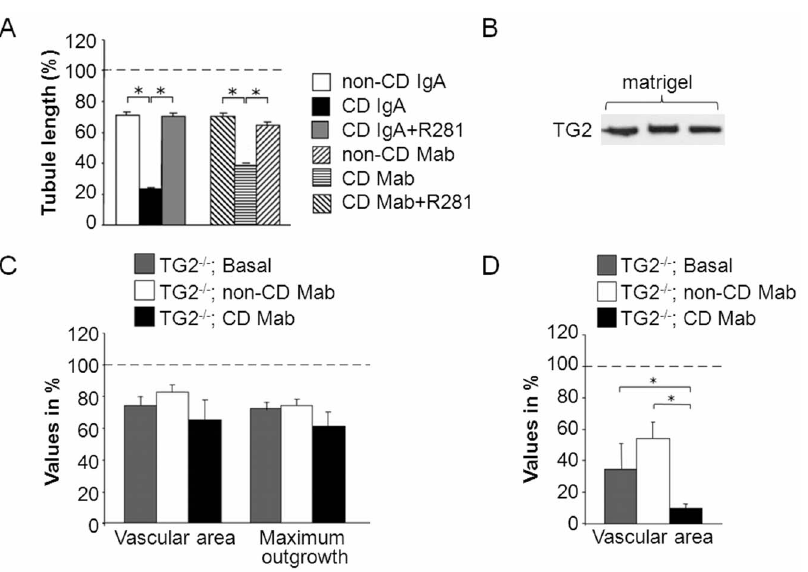
Figure 6. The contribution of extracellular transglutaminase 2 (TG2) in the anti-angiogenic response exerted by celiac antibodies. (A) Endothelial tubule length in three-dimensional human umbilical vein endothelial cell (HUVEC) cultures in the presence of celiac patient-derived total IgA (CD IgA) or monoclonal antibodies (CD Mab), or their relevant controls (non-CD IgA or non-CD Mab) and with/without TG2-inhibitor R281. All data was normalized to the basal group (dotted line). Bars represent the average value as percentage + SEM. * represents P # 0.001 statistical difference (n=9). (B) Western blot using anti-TG2 antibody CUB7402 showing the presence of TG2 in the matrigel. (C) Mouse aorta rings derived from TG2 knockout mice (TG2 2 / 2 ) were cultured inside TG2-containing matrigel for ten days without supplementation (basal) or in the presence of CD Mab or non-CD Mab. After the culture period the vascular area and the maximum outgrowth were measured (n=5 aortas per group). (D) In vivo angiogenesis assays were performed in TG2 2 / 2 mice. Matrigel containing endogenous TG2 was supplemented with CD Mab or non-CD Mab and injected to mice. After eight days the implants were removed and the vascular area determined by anti-von Willebrand factor (vWF)-antibody staining. (n=8 animals per group). Bars in charts C and D represent the average value as percentage + SEM. All data was normalized to the wild type mouse basal group (dotted line). * represents P # 0.01 statistical difference.